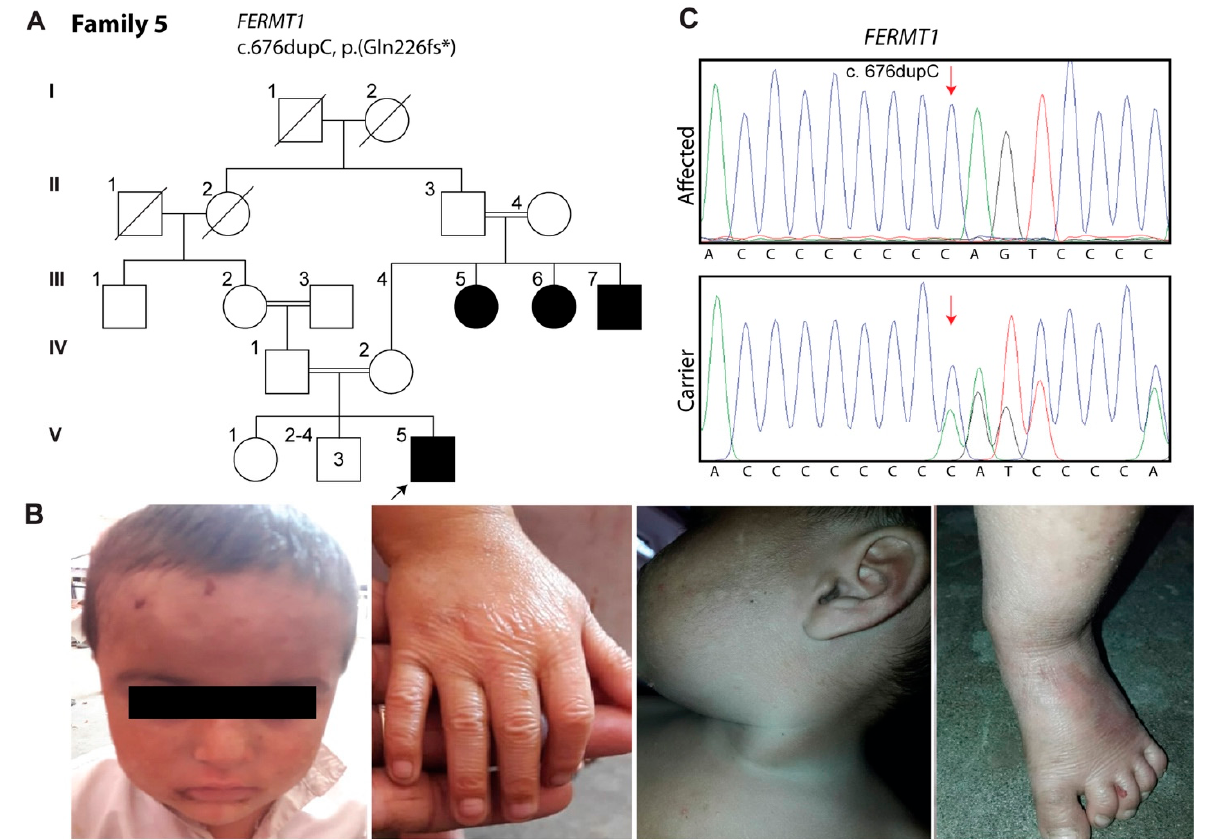
Figure 4. EB phenotype in family 5 is associated with pathogenic variants of FERMT1 . ( A ) pedigree of family 5, ( B ) skin atrophy of hands and feet, absence of poikiloderma, hypopigmentation on the forehead, ( C ) chromatogram showing heterozygosity for identified mutation (c.676dupC) in parents and homozygosity in the patient (V:5). The asterisk indicates premature termination